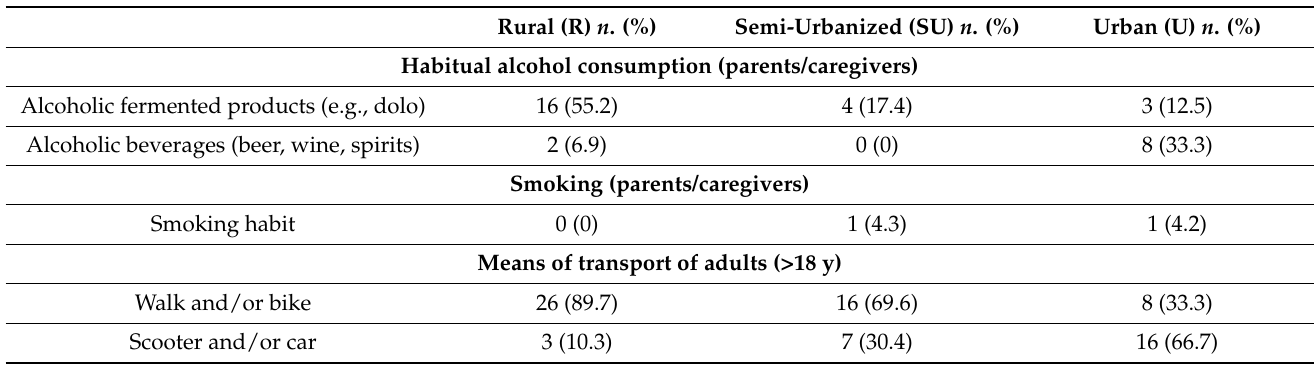
Table 1. Cont. Rural (R) n . (%) Semi-Urbanized (SU) n . (%) Urban (U) n . (%) Habitual alcohol consumption